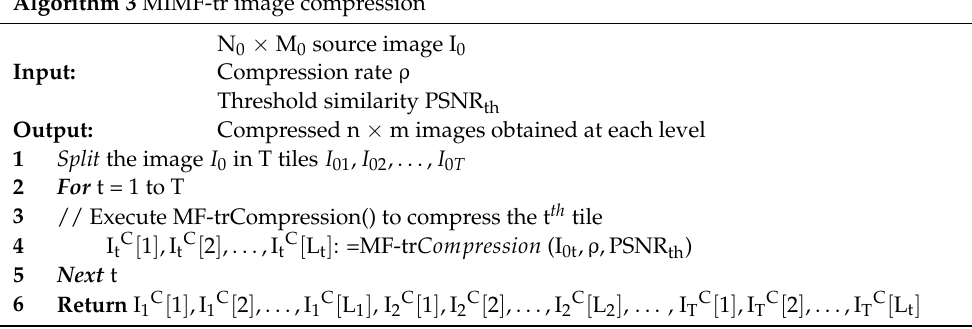
Algorithm 3 MIMF-tr image compression.